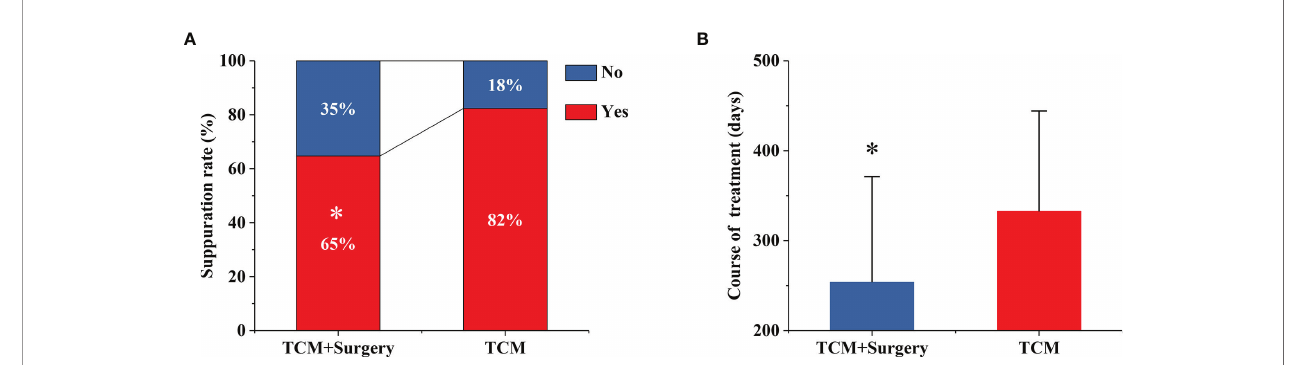
FIGURE 2 | TCM combined with surgery reduce the suppuration rate (A) and total duration of treatment (B) . *P < 0.05 vs. TCM group.